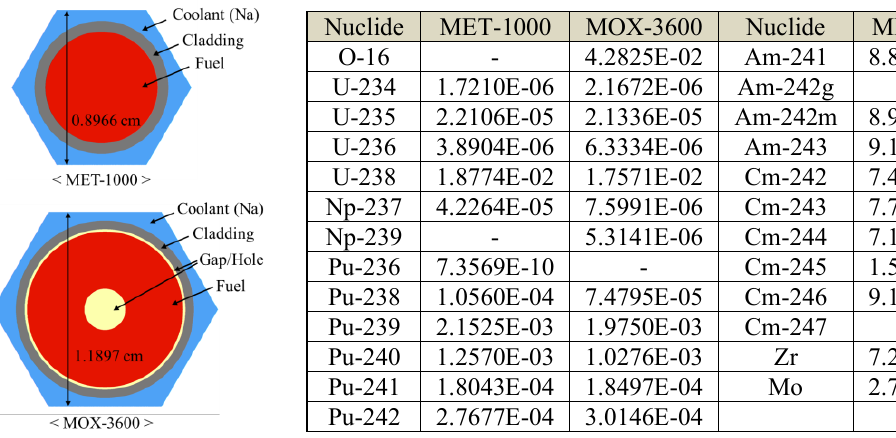
Figure 1. Configuration of pin-cell models, and fuel composition in #/barn-cm